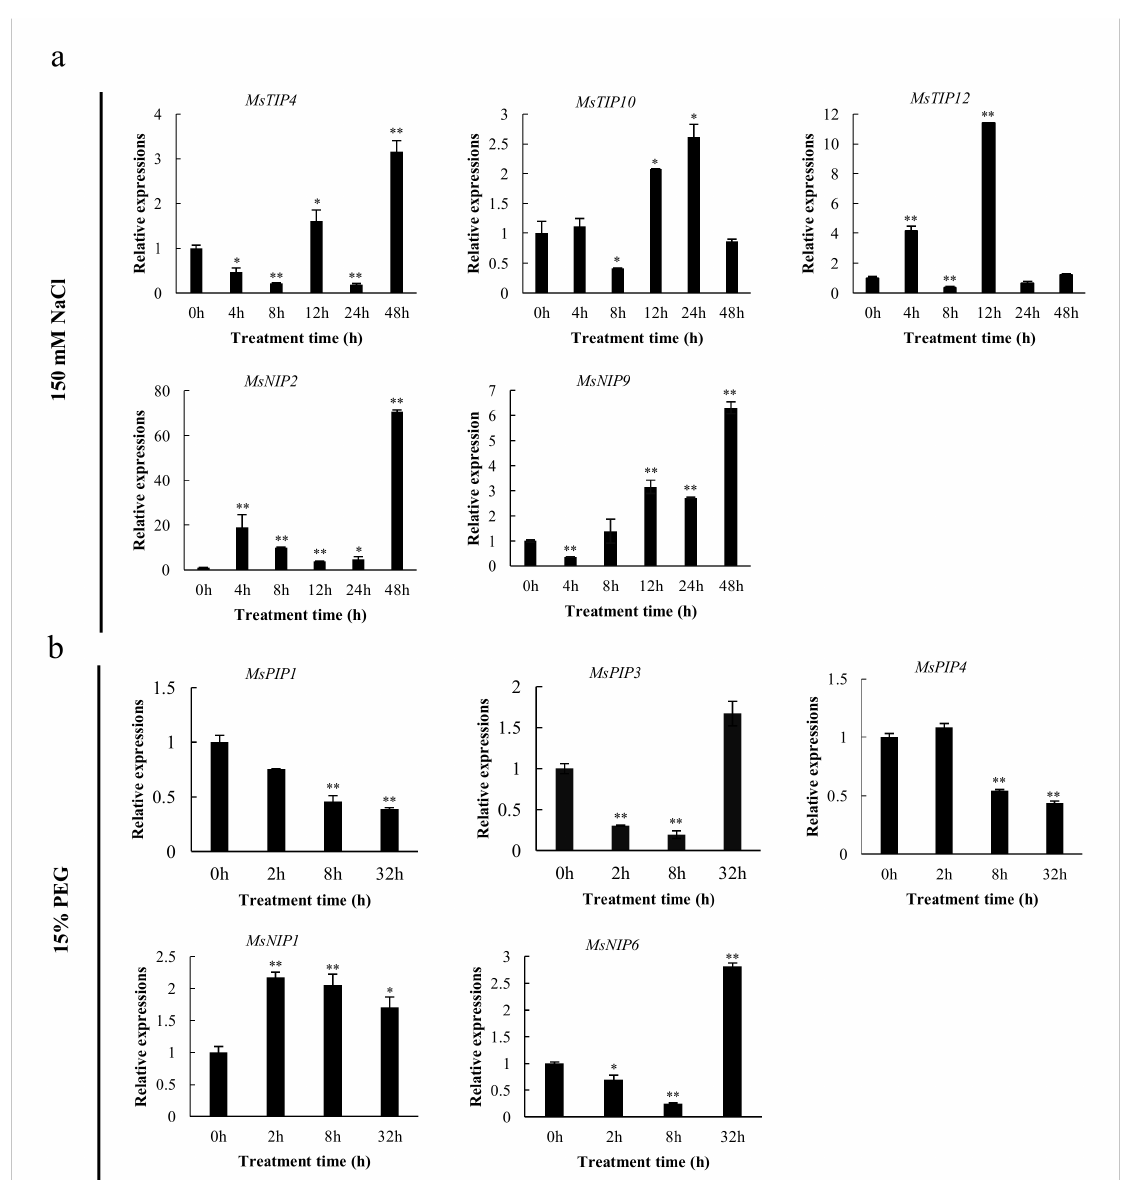
Figure 6. Determination of gene expression levels for 10 MsAQP genes under stresses by using qPCR. Data are the average of three independent biological samples ± SE and vertical bars indicate standard deviation. ( a ) The value of X axis represents treatment period with 150 mM NaCl at 0, 4, 8, 12, 24 and 48 h, respectively; the value of Y axis represents relative expressions of each gene; ( b ) The value of X axis represents treatment period with 15% PEG at 0, 2, 8 and 32 h, respectively; the value of Y axis represents the relative expression of each gene. Data are presented as mean ± SD, Student’s t -test ( n = 3, * p <0.05, ** p